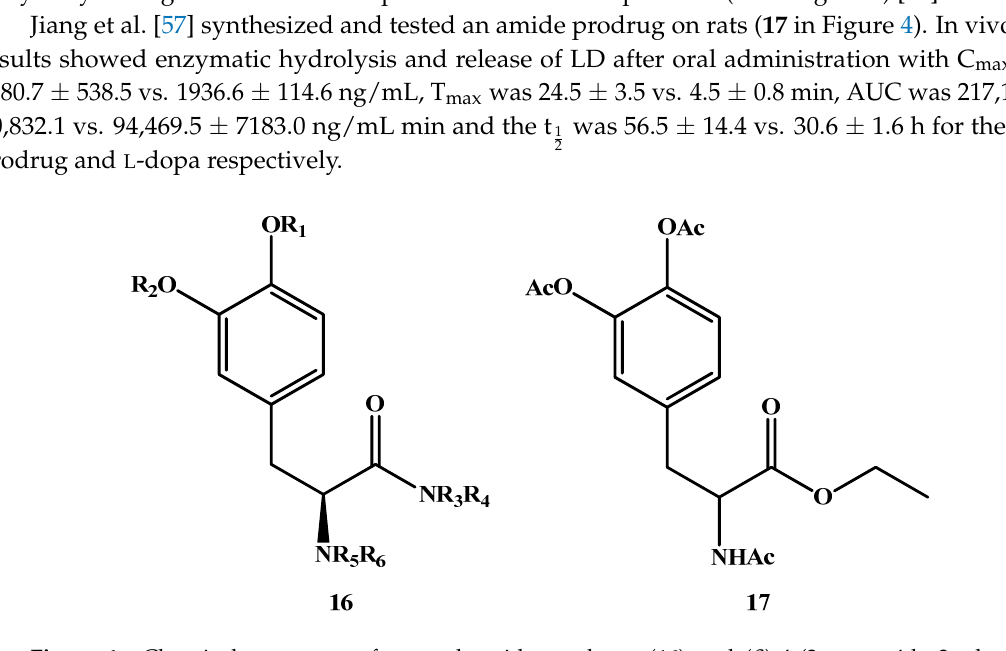
Figure 4. Chemical structures of general amide prodrugs ( 16 ) and ( S )-4-(2-acetamido-3-ethoxy- 3-oxopropyl)-1,2-phenylene diacetate ( 17 ).